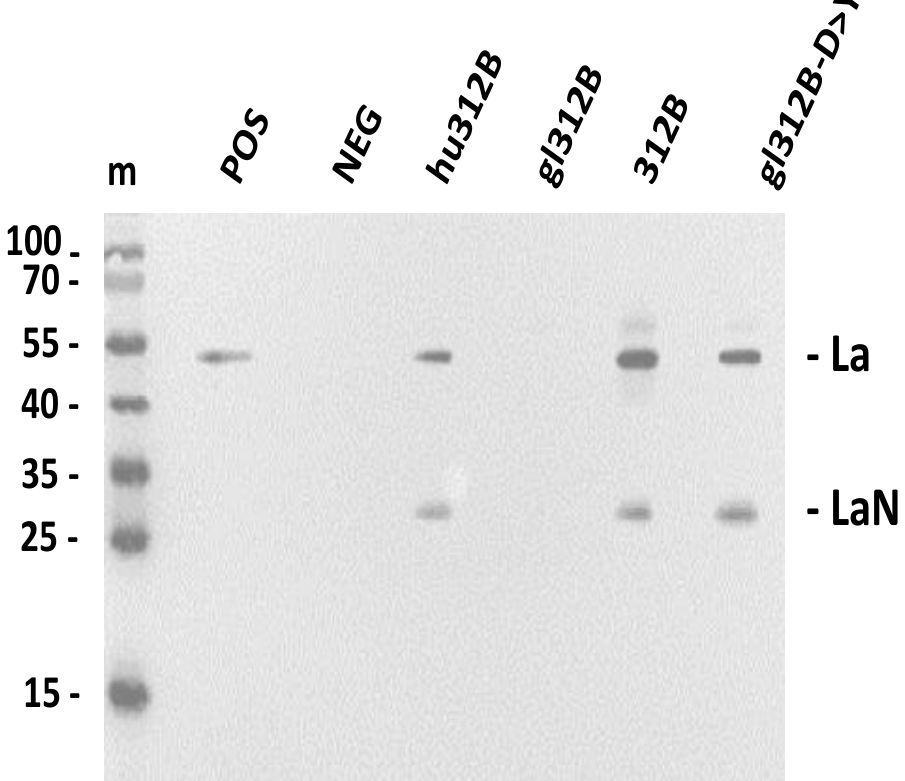
Figure 4. Co-immunoprecipitation of native human La protein. Native human La protein present in total HeLa cell extract (as confirmed in the positive control (POS)) was co-precipitated with the respective 312B ab derivate, including the humanized 312B ab (hu312B); the germline 312B ab, in which all SHMs were mutated back to the germline sequence (gl312B); the mature, murine 312B ab (312B); and the germline ab variant of 312B, in which the aspartate residue in the V H CDR3 region was replaced by a tyrosine residue (gl312B-D > Y). Co-precipitated native human La protein was detected by SDS-PAGE/immunoblotting using the anti-La mab 5B9 and anti-mouse IgG abs-conjugated with peroxidase. POS, positive control (HeLa extract); NEG, negative control (PBS); m, protein ladder; La, human La protein; LaN, N-terminal proteolysis product of La protein.